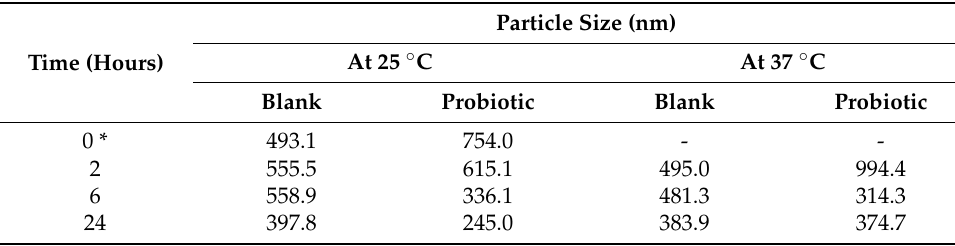
Table 3. Particle size of probiotic-loaded vaginal suppositories